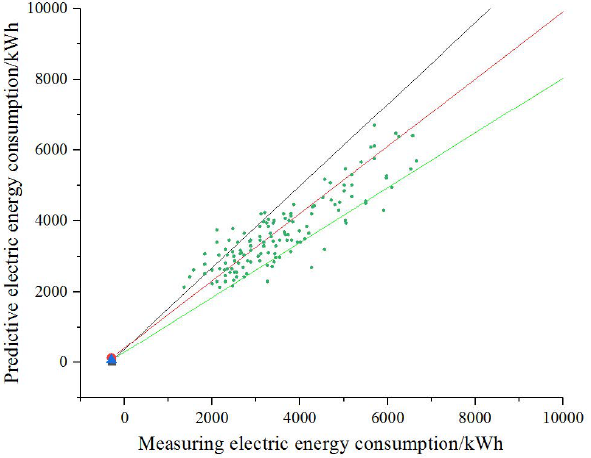
Fig. 3 Distribution scatterplot of predicted and measured values of average residential power